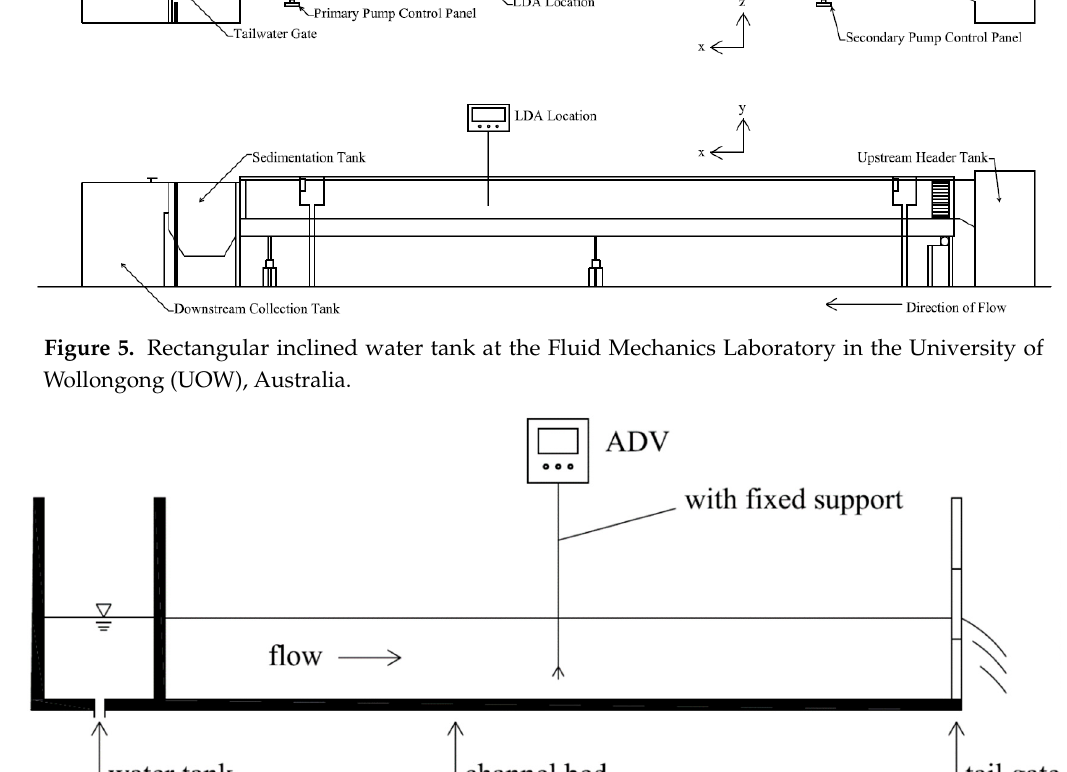
Table 1. Summary of all the experimental conditions.